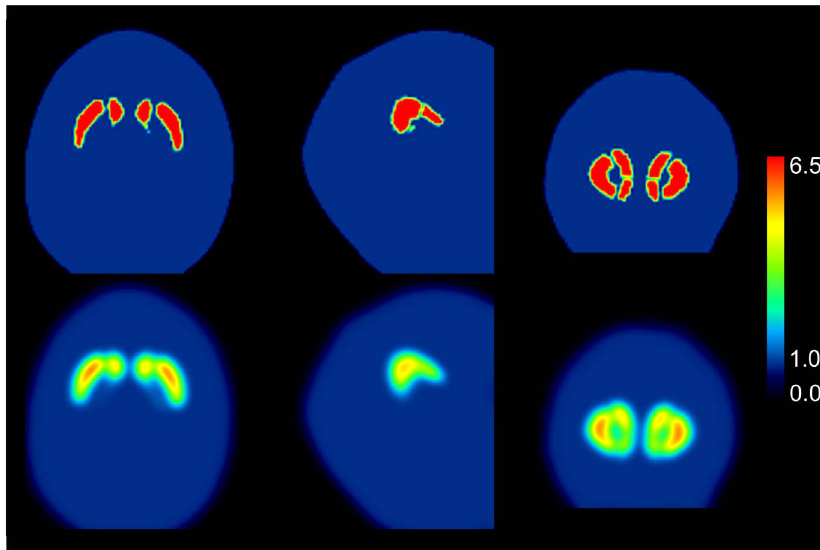
Figure 5. SPECT underestimates the true activity concentration in small structures such as the striatum and its substructures due to the limited spatial resolution in the reconstructed SPECT image (partial volume effect, PVE). In order to estimate the extent of underestimation in the present study, the reconstructed spatial resolution was estimated on the basis of a line source measurement using the same acquisition and reconstruction protocol as in the measurements of the striatal phantom and the patients included in the present study (no AC). Spatial resolution was found to be about 8 mm full-width-at-half-maximum (FWHM). Then a high-resolution CT of the striatal phantom was segmented manually (top row; from left to right: transversal, sagittal and coronal slice). Voxel values in the striatum were set to 6.5, voxel values in the background to 1.0 in order to simulate the actual SBR of about 5.5 in the phantom studies (Table 1). Then the segmented CT image was smoothed with a 3-dimensional Gaussian kernel with 8 mm FWHM to simulate the PVE in SPECT (bottom row). ROI analysis of the smoothed image resulted in a striatal SBR of 3.2 which underestimates the actual SBR of 5.5 by about 42%. doi:10.1371/journal.pone.0108328.g005 The lack of an impact of AC on the diagnostic power of I-123- individual raters nor the consensus scores obtained at each centre ioflupane SPECT was confirmed by the results of the visual showed an effect of AC on their diagnostic value. This finding is in interpretation of the SPECT images. Neither the scores of the 6 agreement with the results of Bienkiewicz and colleagues who